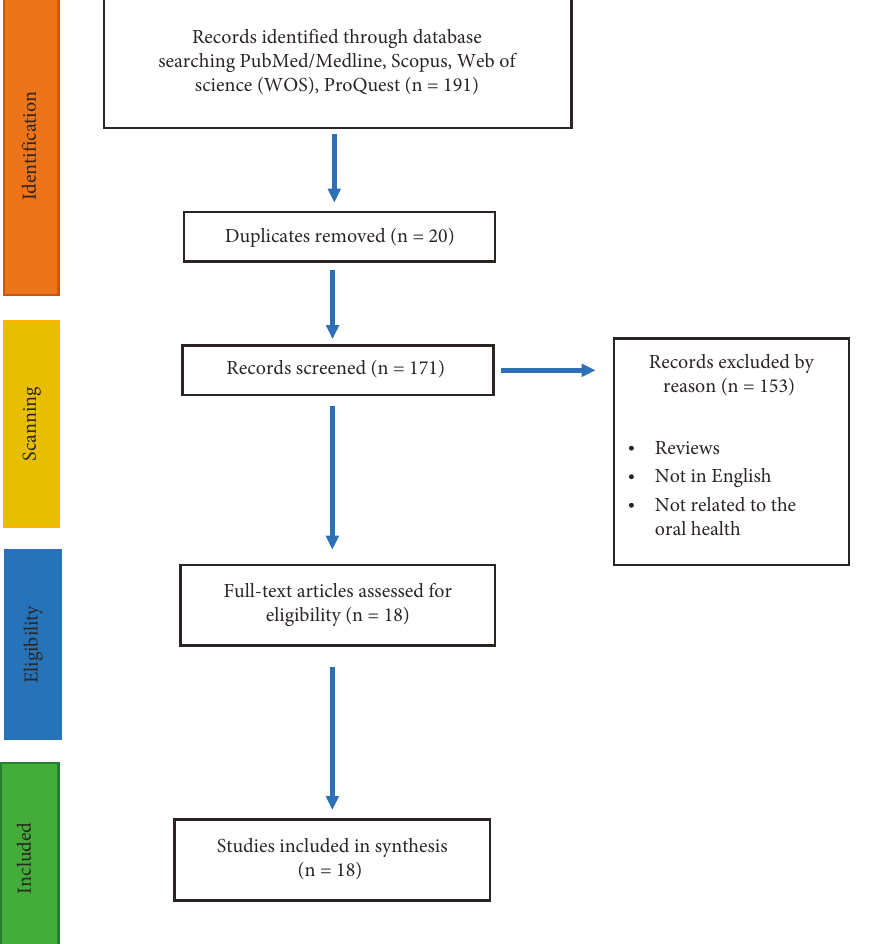
Figure 1: PRISMA flow